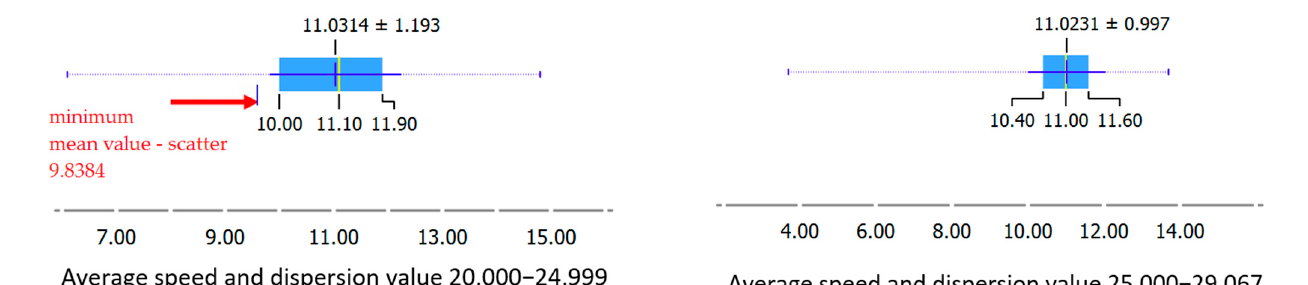
Figure 3. Ship’s speed values (mean value ± scatter).